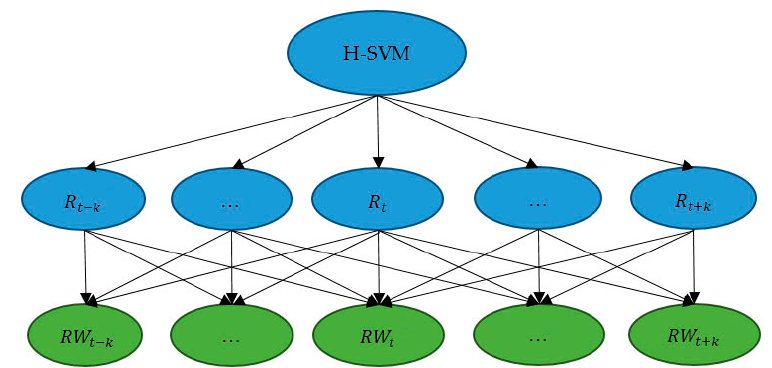
Figure 2. The context-based classification.